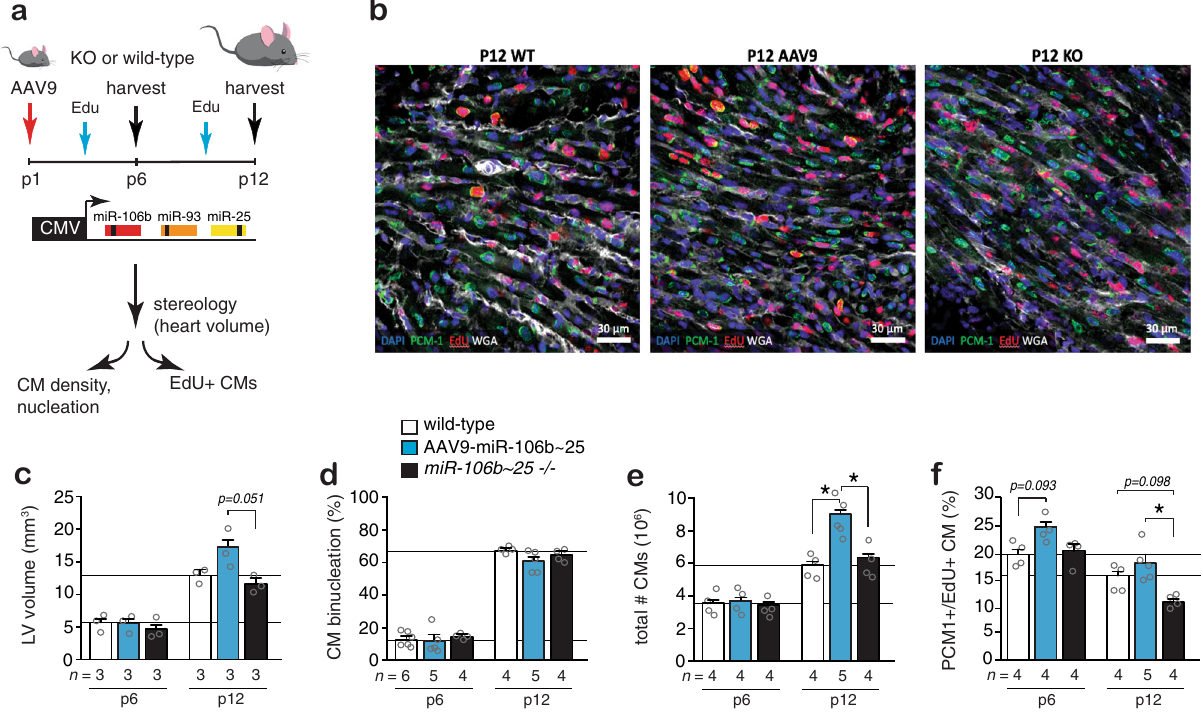
Fig. 4 The miR-106b~25 cluster controls the total number of CMs. a Work fl ow of the study. b Representative confocal images of sections co-stained for pericentriolar material 1 (PCM-1), 4 ′ ,6-diamidino-2-phenylindole (DAPI), EdU, and WGA to assess PCM-1 + EdU + CMs in the experimental groups at p12. Quanti fi cation of c LV volumes, d percentage CM binucleation, e total number of CMs and f proliferating (PCM-1 + , EdU + ) CMs at p6 and p12 in the experimental groups, n refers to number of hearts. * P < 0.05 vs corresponding control group (error bars are s.e.m.). Statistical analysis consisted of a One- way ANOVA followed by Dunnett multiple comparison test ( c – f ). Source data are provided as a Source data fi